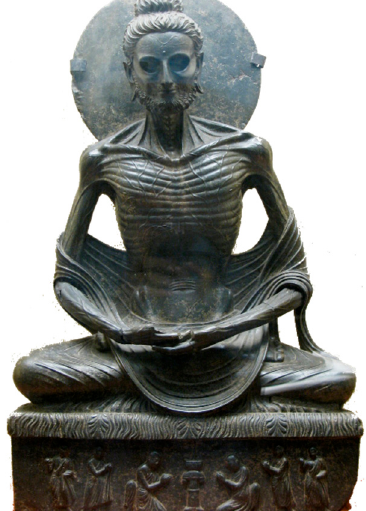
Figure 4. The Buddha as the body of the ascetic. The signs of the austere practice of renunciation are clearly visible in a body mortified by extreme asceticism. Lahore Museum PB‑94 (original photo by Syed Muhammad Naqvi, CC BY‑SA 3.0, Wikimedia Commons).